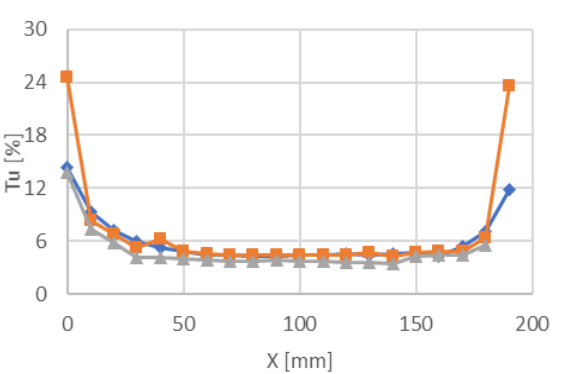
Fig. 13. Turbulent intensity, mean velocity of 21 m/s .